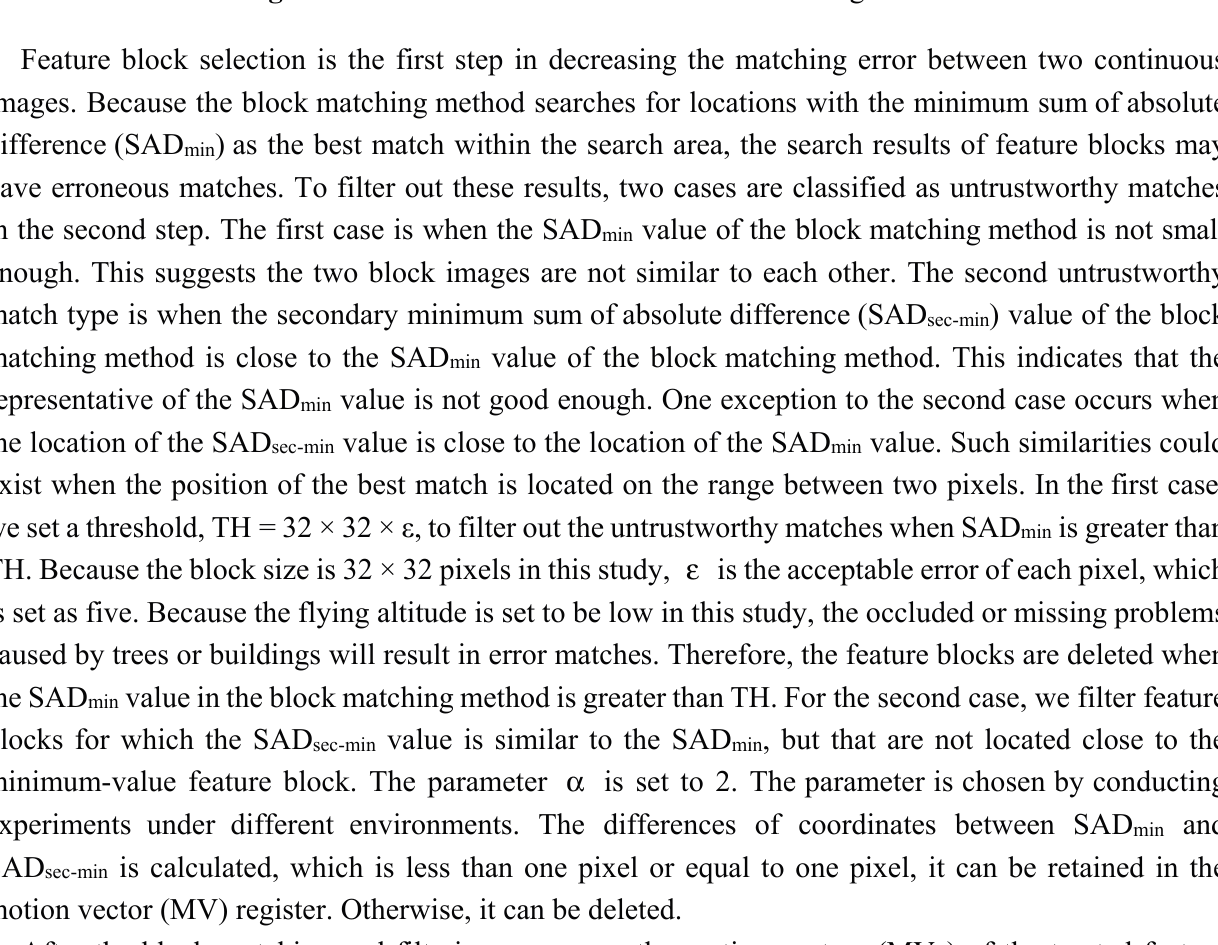
Figure 4. Search area of full-search block matching